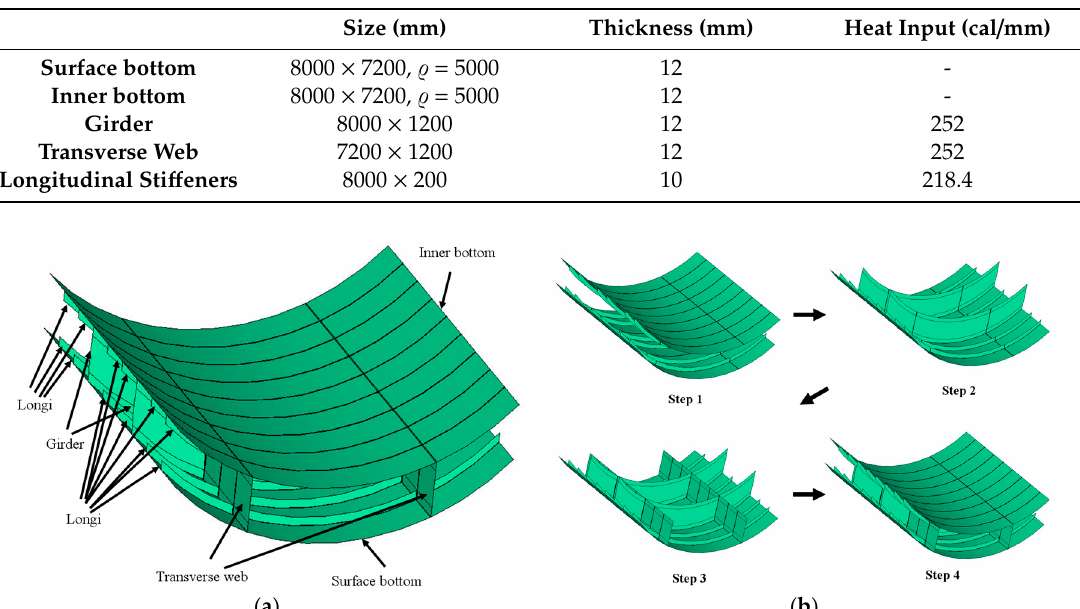
Figure 13. Analysis model: ( a ) curved double bottom block, ( b ) welding sequence.